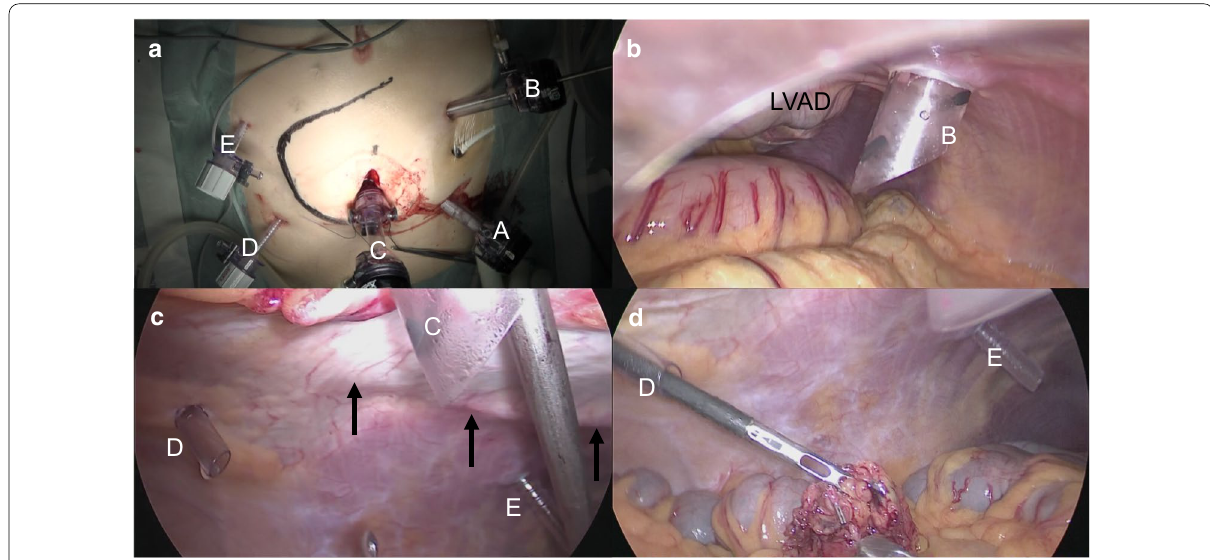
Fig. 3 The trocar insertion sites from the body surface ( a ) and the abdominal cavity ( b , c , d ). A 12-mm port for the telescope; B 12-mm port for the surgeon’s right-hand device; C 12-mm blunt port for the surgeon’s left-hand device; D , E 5-mm ports for the assistant’s devices. All ports were inserted away from the driveline (black arrow) and the